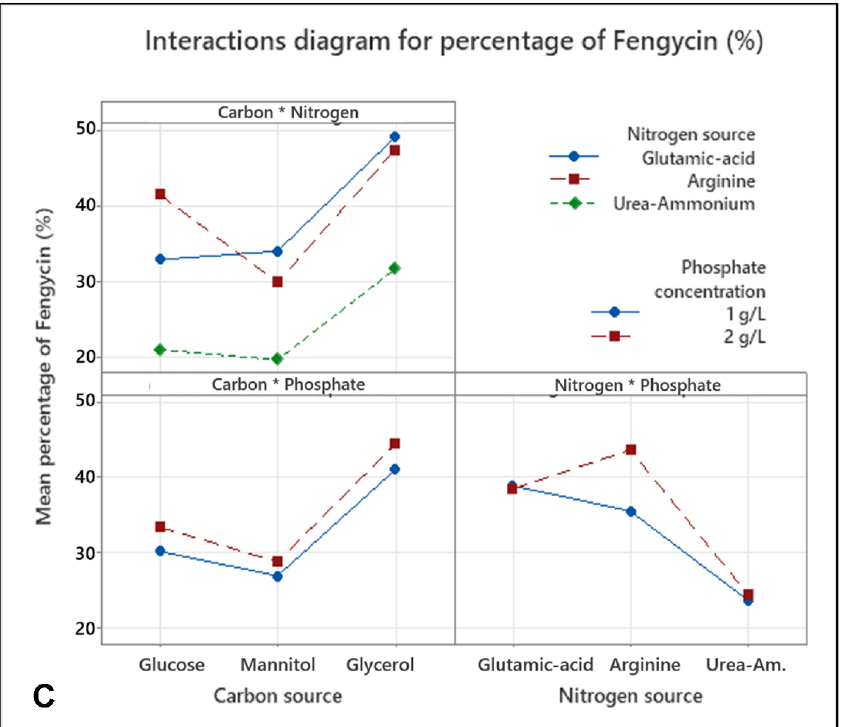
Figure 5. Interaction diagrams for ( A ) fengcyin specific production, ( B ) surfactin specific production and for ( C ) Percentage of fengycin produced related to total lipopeptides. * indicates the interaction between the factors.